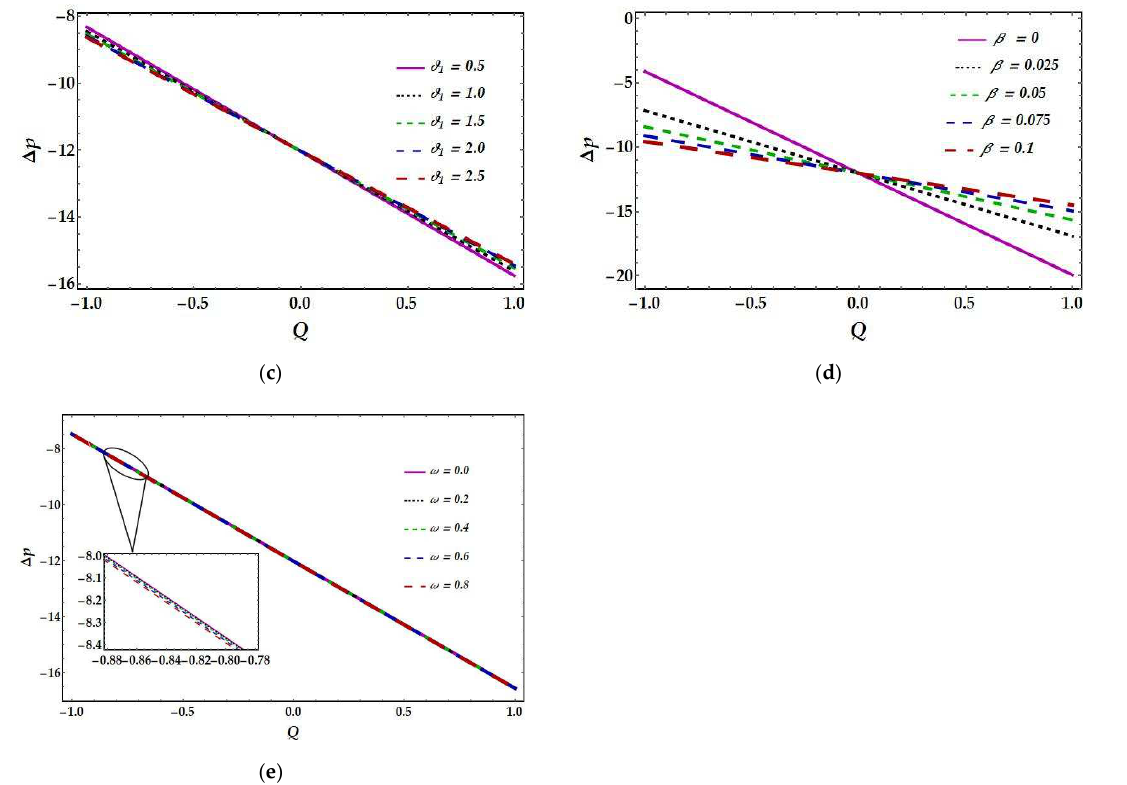
Figure 6. Effects of different physical parameters on pressure rise ∆ p 4.6. Temperature Profile